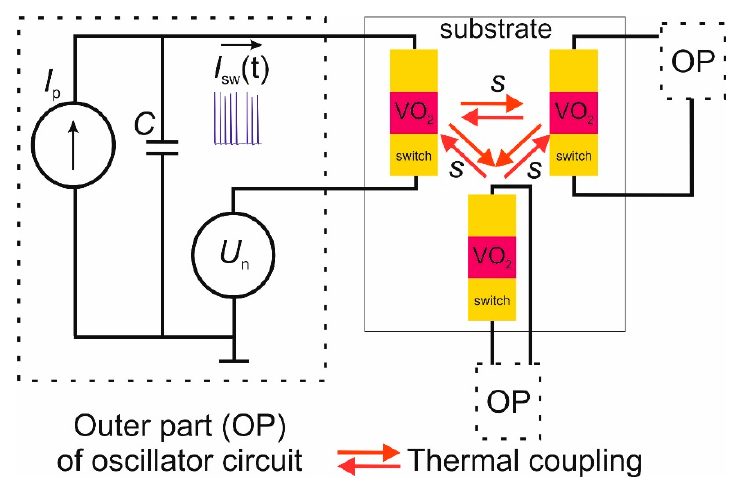
Figure 1. The oscillator circuit and example of oscillators’ interaction via thermal coupling of VO 2 switches. I sw ( t )—current signal in a VO 2 switch, that leads to its Joule heating resulting in thermal impulses that spread along the substrate; U n —source of noise, s —thermal coupling strength.